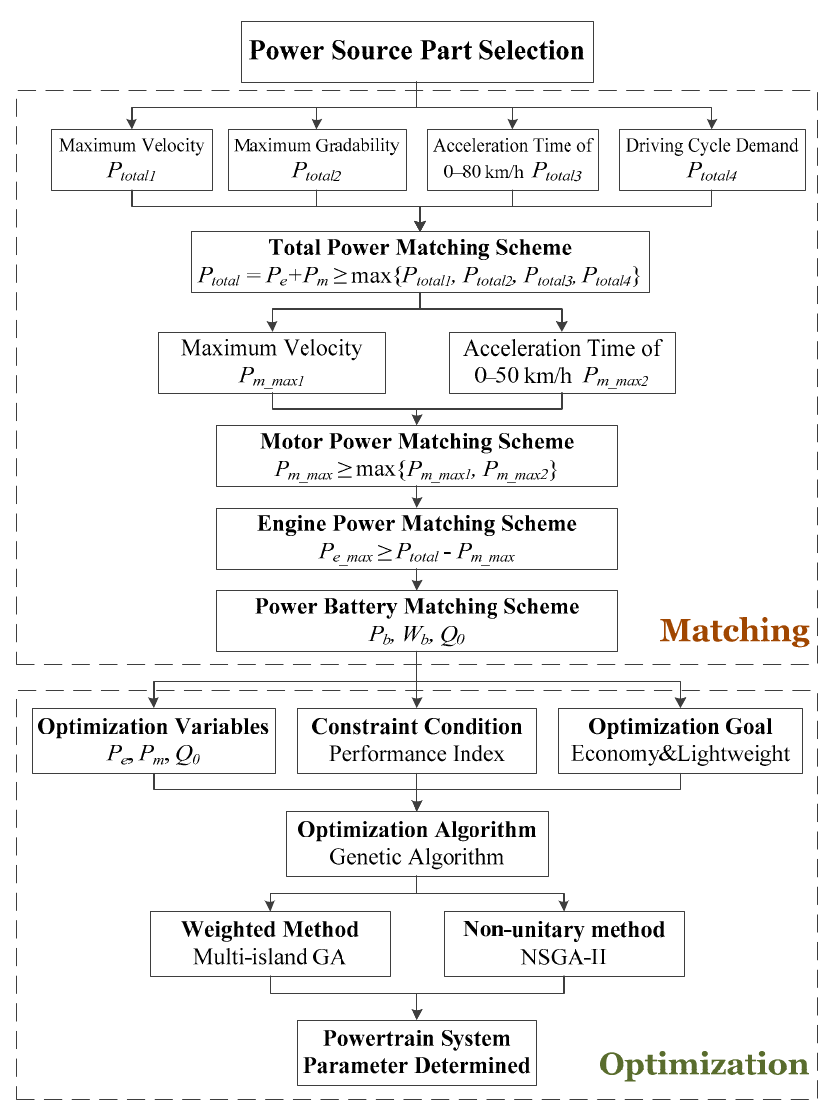
Figure 5. Optimization and matching design process of PHEV power sources.